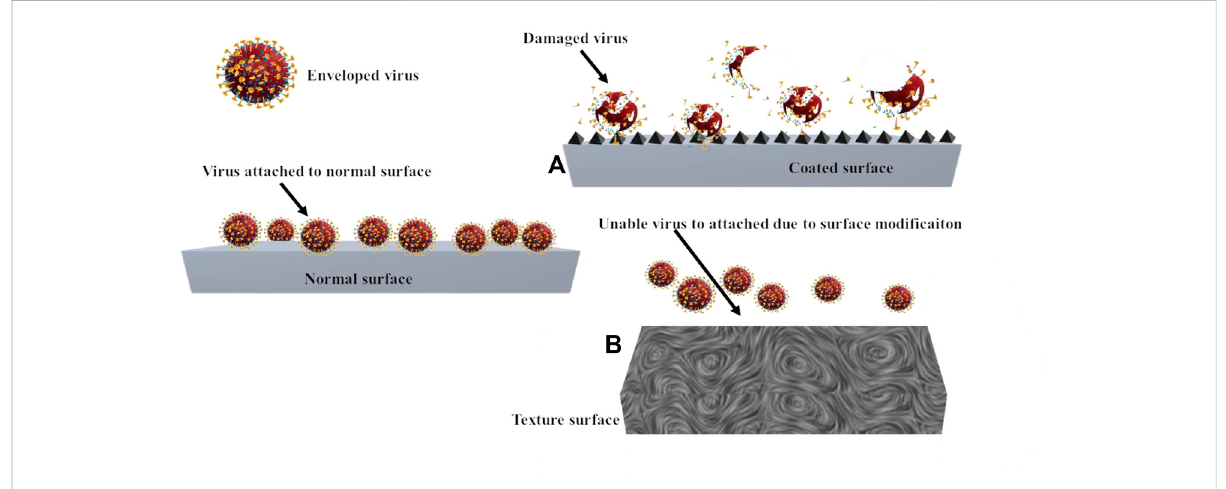
FIGURE 2 Texturing of the surface with fullerene derivatives for virus inactivation. By surface modi fi cation (A) . Fullerene-textured surface (B)